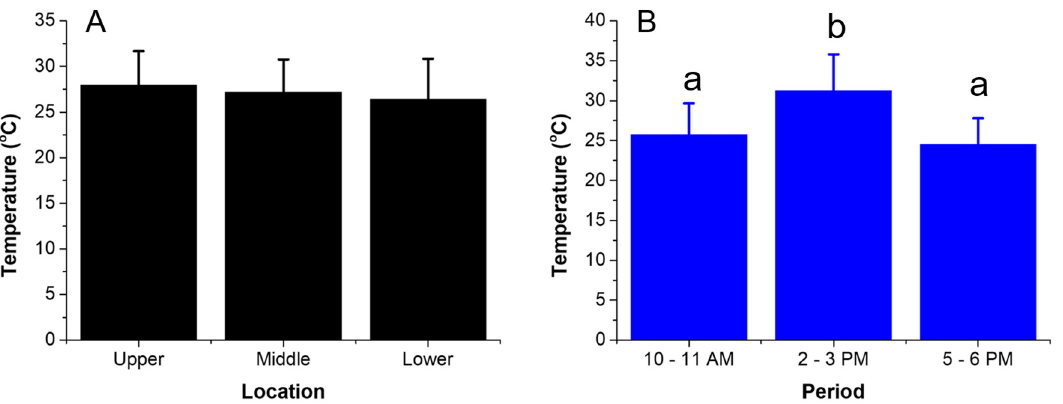
Figure 11. Data represent means and standard deviation (SD) of air temperature in the experimental greenhouse for location-wise temperature variation ( A ) and period-wise temperature variation ( B ). Different letters above the bars (SD) denote significant differences in air temperature among the three periods at p ≤ 0.05 based on Tukey’s HSD post-hoc test.